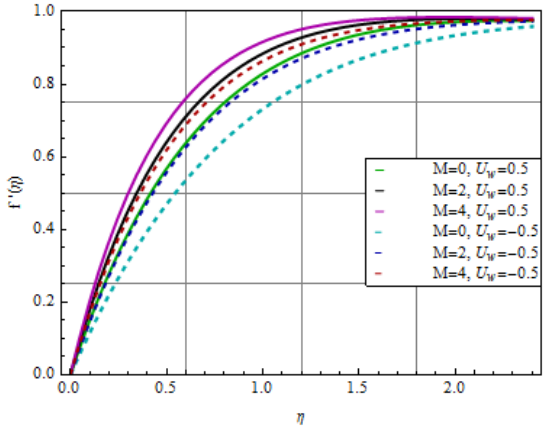
Fig. 15: The velocity distribution for alumina-sodium alginate nanofluid for different values of unsteadiness and wall transpira- tion parameters with M = 1, ε = 0, λ = 1, Pr = 6.2, ϕ = 0.2.